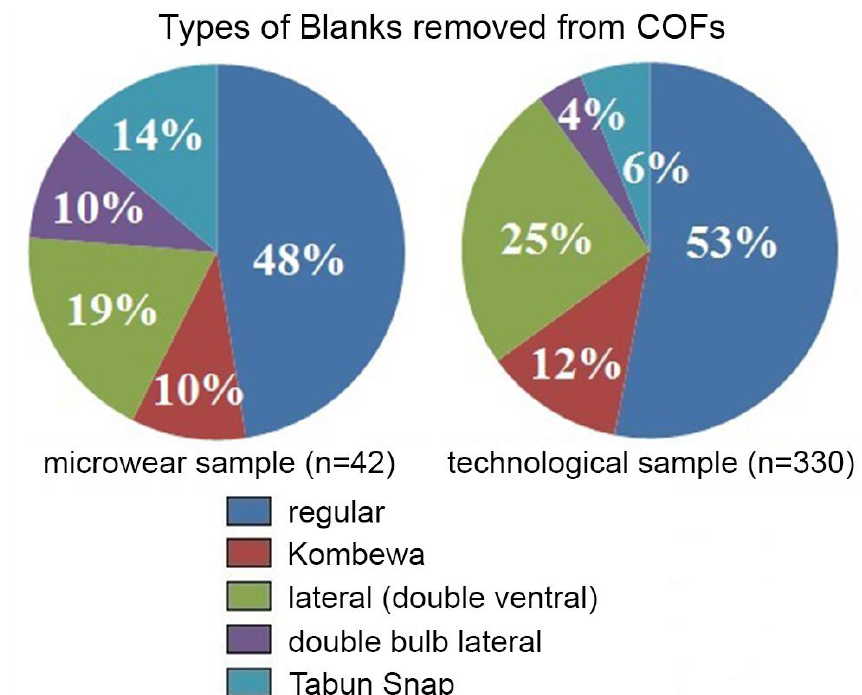
Figure 2. Percentage of types of blanks struck from COFs in the microwear sample (n=42) left, and the larger technological sample (n=330). One WR blank examined for microwear (listed as varia on Table 1) could not be classifed, and the PPNB blank was not included. See Barkai et al . (2010); Lemorini et al . (2014); and Parush et al . 2018 for details on